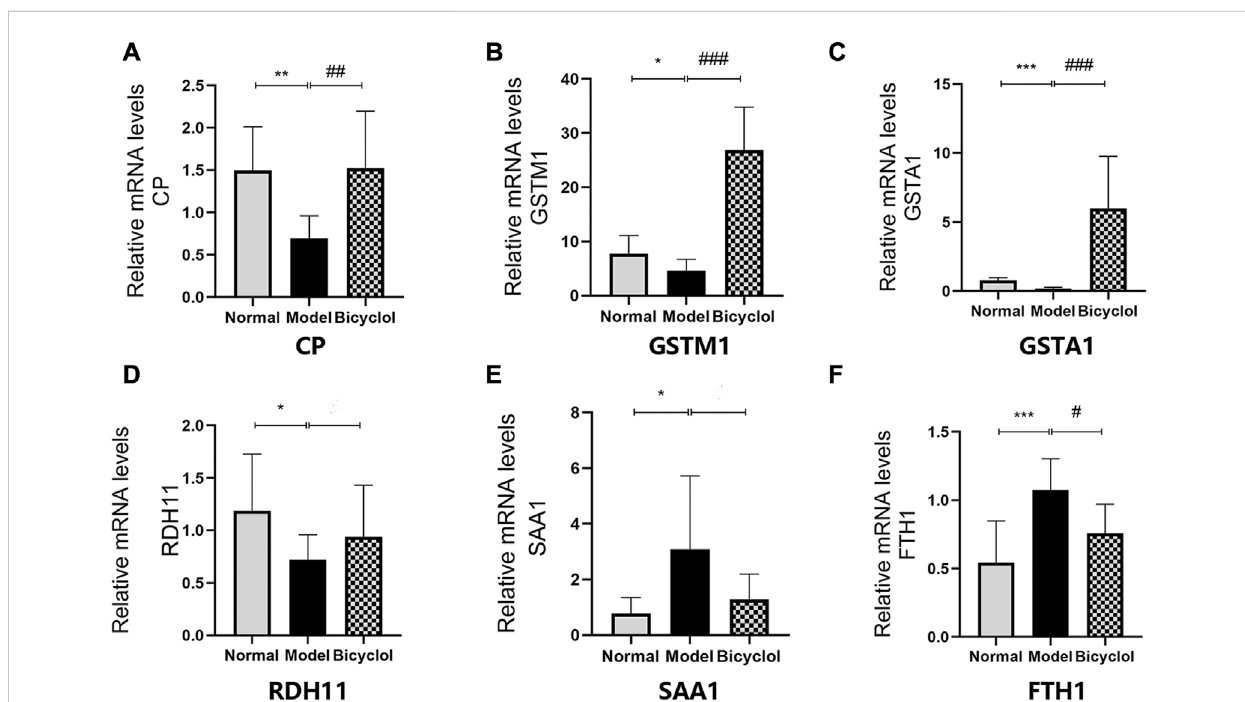
Expression of the genes involved in in fl ammation and oxidative stress mechanism. Relative mRNA levels of (A) CP (n = 8), (B) GSTM1 (n = 8), (C) GSTA1 (n = 8), (D) RDH11 (n = 8), (E) SAA1 (n = 5), (F) FTH1(n = 8). * p < 0.05 vs Normal, ** p < 0.01 vs Normal, *** p < 0.001 vs Normal, # p < 0.05 vs